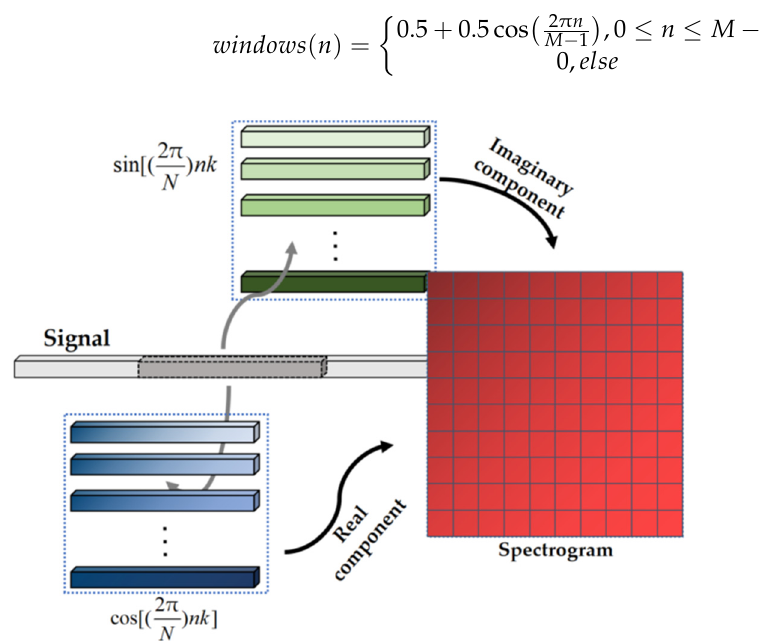
Figure 5. The schematic diagram of the BSTFT-CNN.